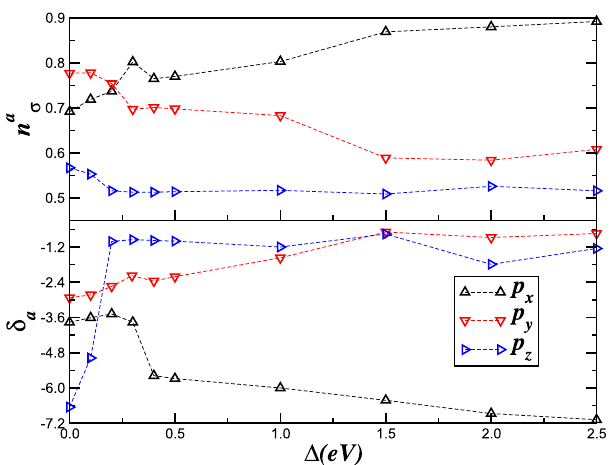
Figure 5. Effect of the orbital “Zeeman” field upon pressure. (Top) LDA + DMFT results for the orbital occupations σ n a and (bottom) the renormalized orbital splittings δ a . Notice that σ n y jumps at the insulator-metal transition, a behavior characteristic of orbital-selective Mott